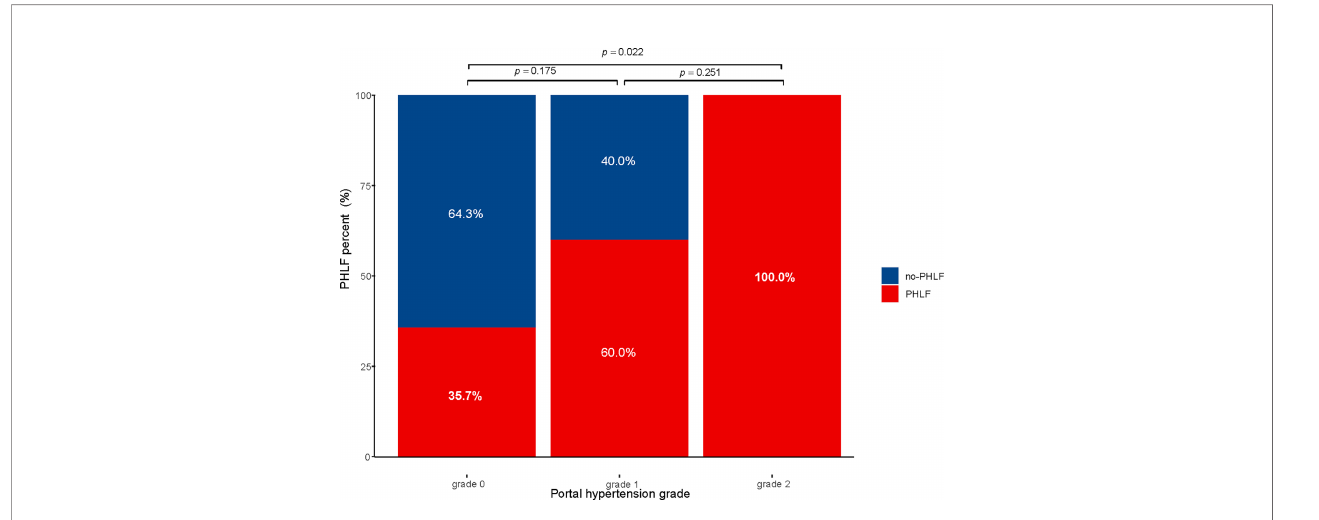
FIGURE 2 | Incidence of PHLF with extensive liver resection in patients with hepatocellular carcinoma PHLF, post hepatectomy liver